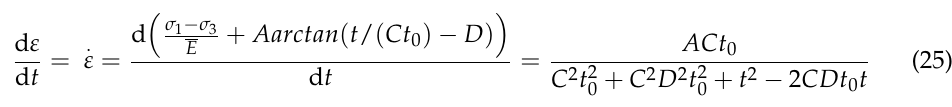
Figure 37. Comparison of theoretical and practical strain rate–time of ADS = 37.98 kPa of Specimen 23.